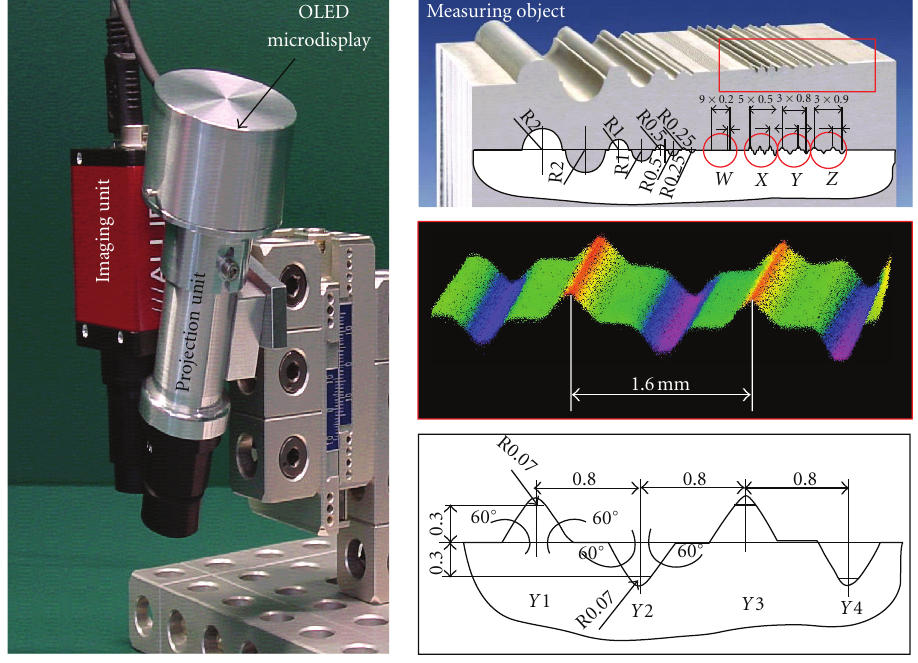
Figure 1: Principle design (left) and prototype (right) of the 3D surface metrology system based on one projection and one imaging unit.